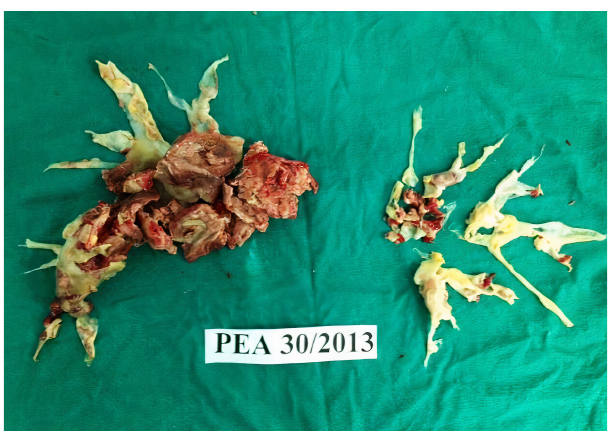
Fig. 1 - Operation material extracted from a patient. PEA=pulmo- nary endarterectomy